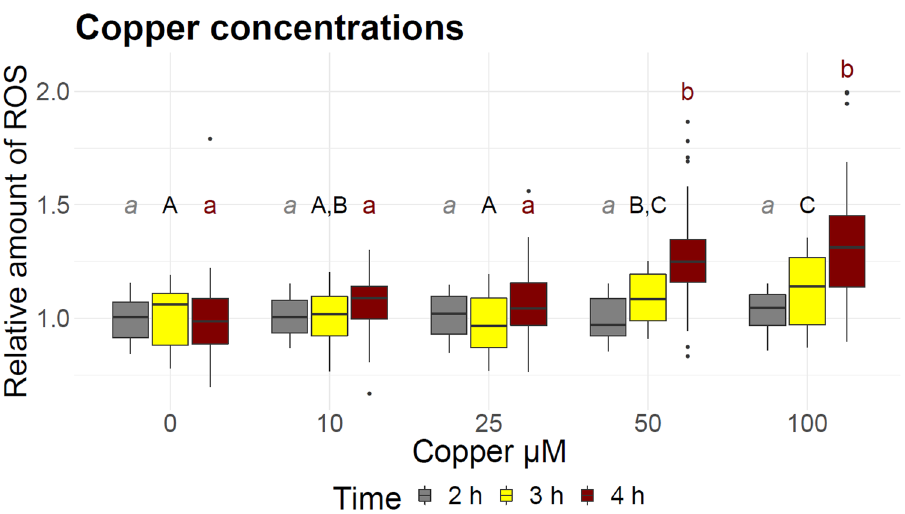
Figure 1. Relative amount of reactive oxygen species (ROS) in larvae exposed to different concentrations of copper. Fluorescence was measured after 2 h, 3 h, and 4 h of incubation with the fluorescence dye. Different letters of the same color represent significant differences within one time-point. ANOVA-HSD, n = 36, df = 4, p <